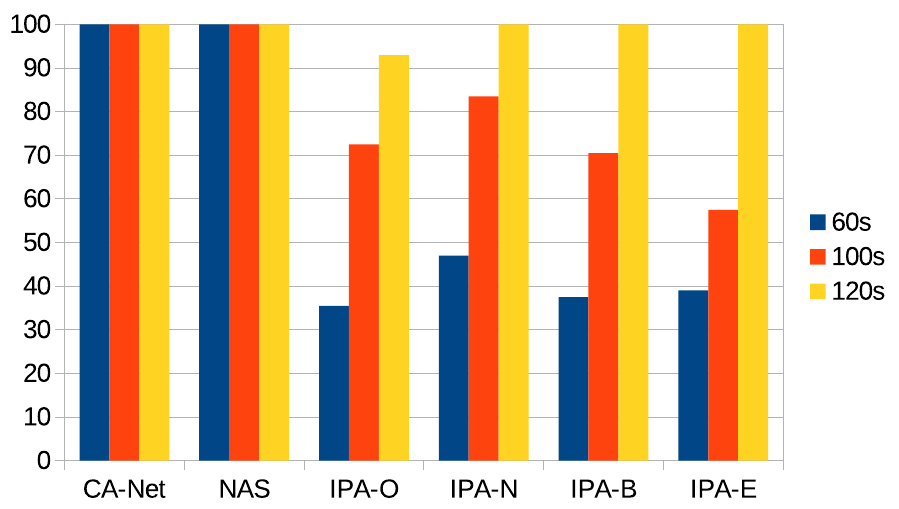
Figure 4. Percentage of accepted jobs for each deadline.